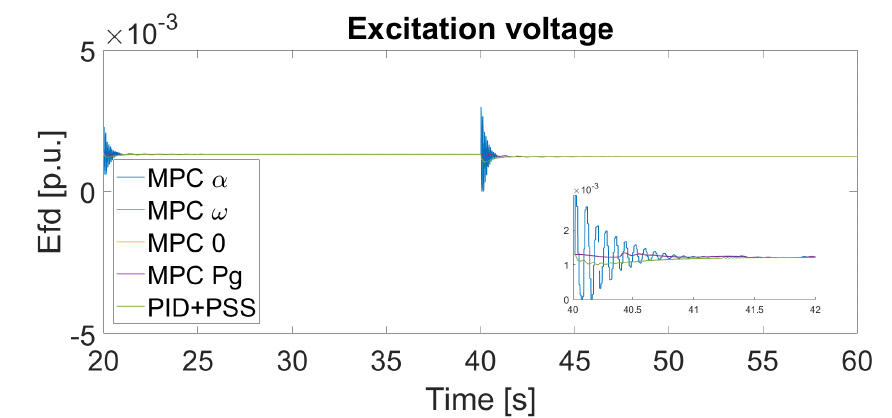
Figure 14. Excitation voltage (set active power set step). Table 6. Integral quality indices ( × 10 − 4 )—superior results marked in